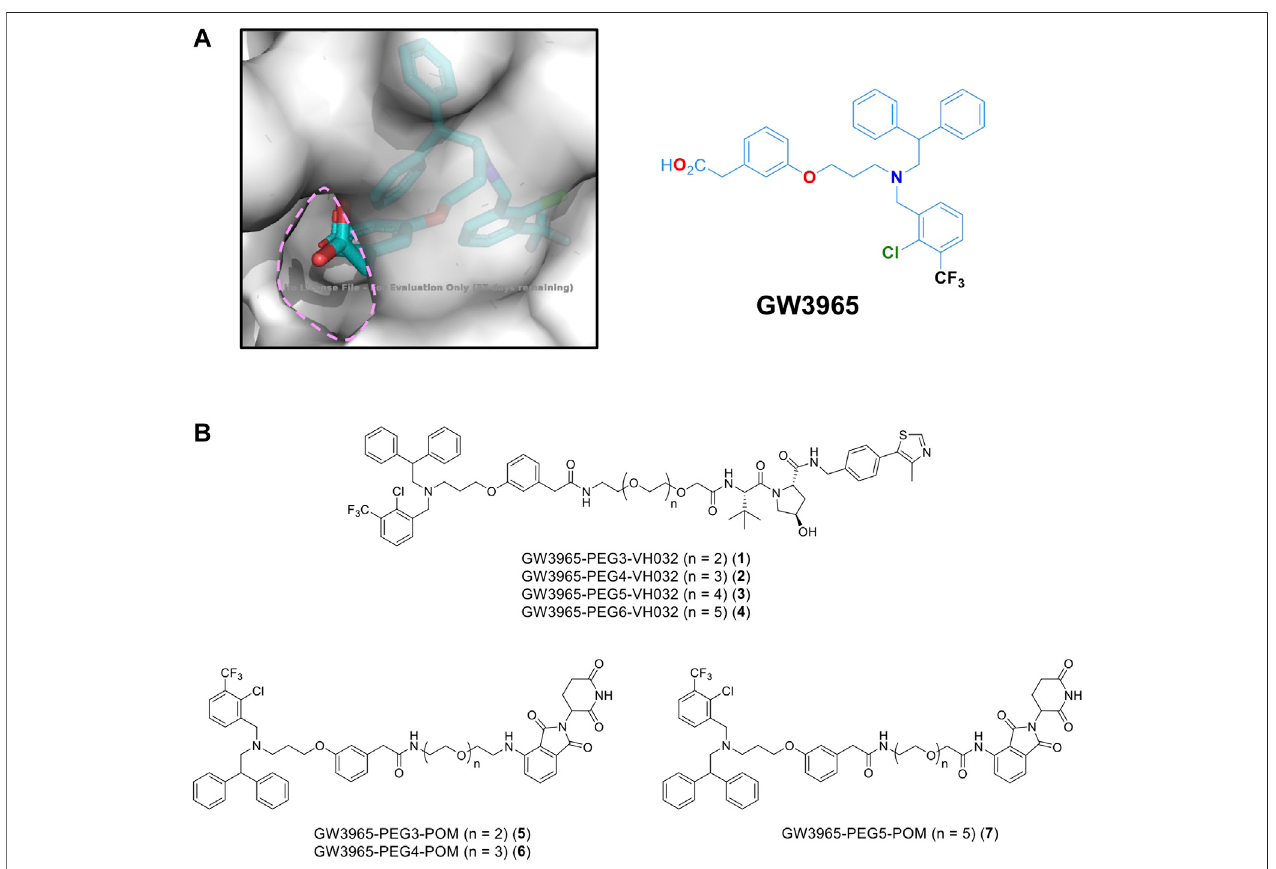
FIGURE 1 | (A) X-ray crystal structure of a GW3965-LXR α complex (PDB: 3IPQ). (B) Designated PROTACs in this study.